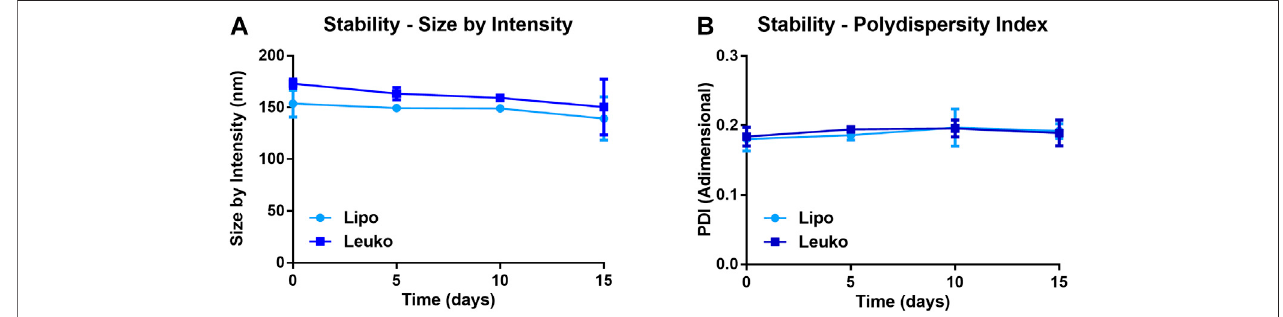
FIGURE 4 | Multiplex fl ow cytometry analysis of Leuko markers for detection of immune cells (A) and molecules involved in cell adhesion and activation (B) . The x-axis shows the protein marker pro fi le, whereas the y-axis represents the normalized APC-MFI. The median APC signal intensity ofeach speci fi c Leuko surface marker was normalized to the median of each Lipo surface marker. MFI, median fl uorescence intensity.